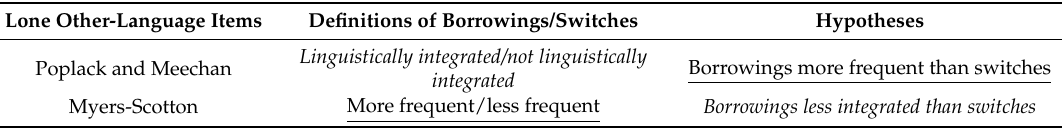
Table 1. Definitions vs. hypotheses: Poplack and Meechan vs. Myers-Scotton.